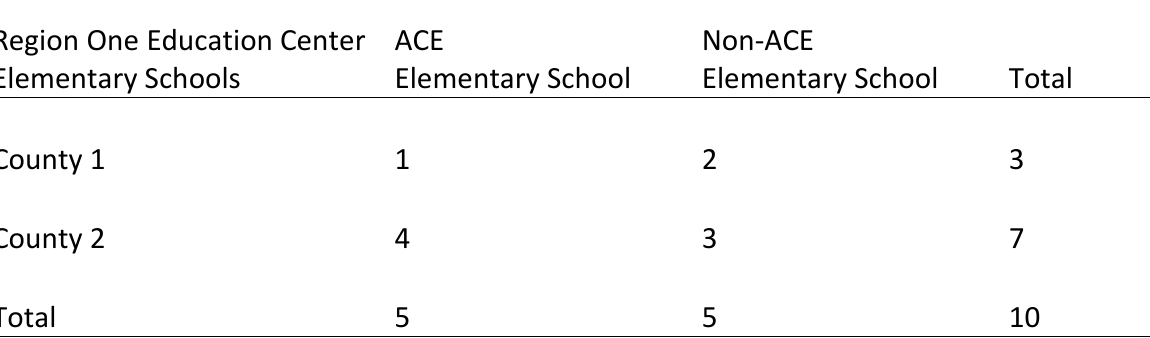
Table 1 : Descriptive Statistics on the campus implementation and non-implementation of the 21 st Century Afterschool Centers on Education for 4 th grade